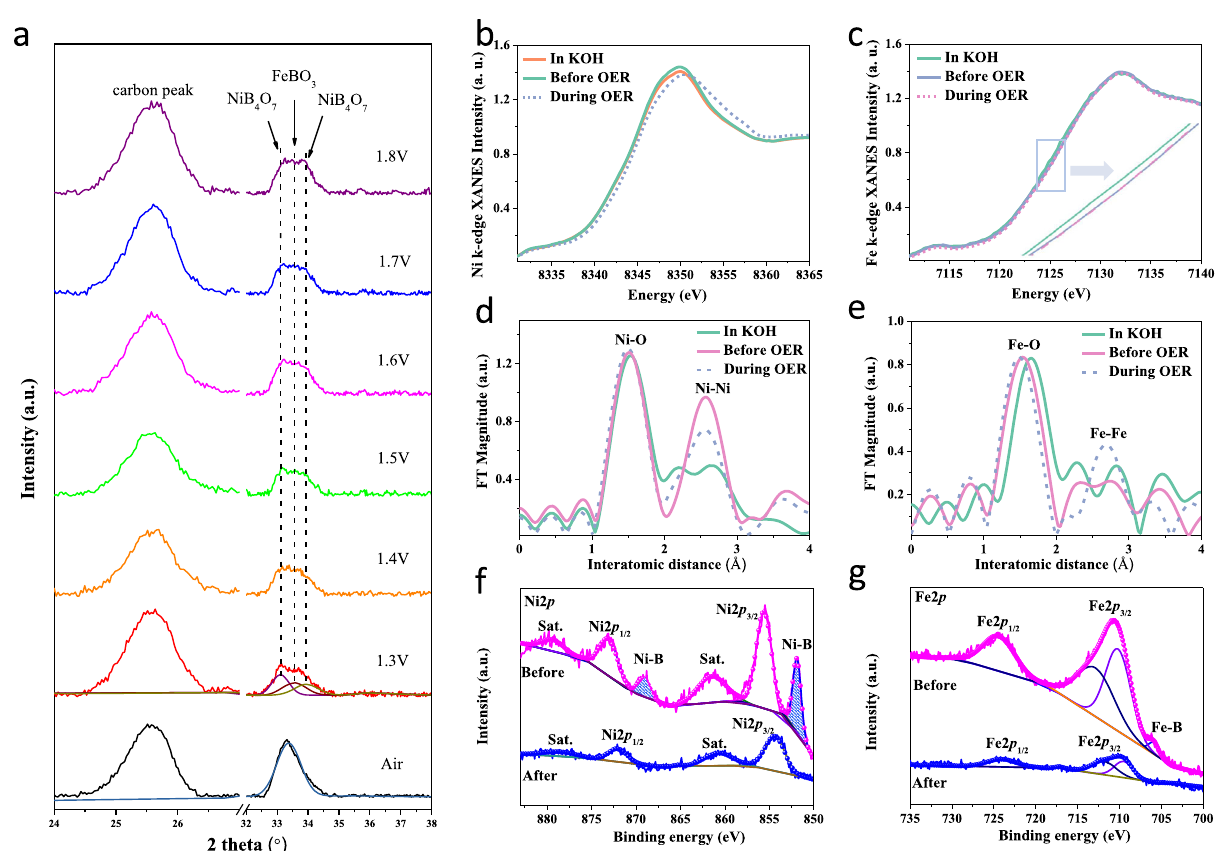
Fig. 3 Ex/in-situ characterization of as-prepared NiFe-Boride catalyst. a In-situ SRXRD patterns of the catalyst during the OER test in 1 M KOH electrolyte; The in-situ Ni and Fe K -edge XANES ( b ) and ( c ) and EXAFS ( d ) and ( e ) data of NiFe-Boride during the LSV process in 1 M KOH aqueous electrolyte. The in-situ applied voltages before and during the OER are 1.2 and 1.4 V vs. RHE, respectively. f Ni 2 p and ( g ) Fe 2 p XPS spectra for fresh and post-OER